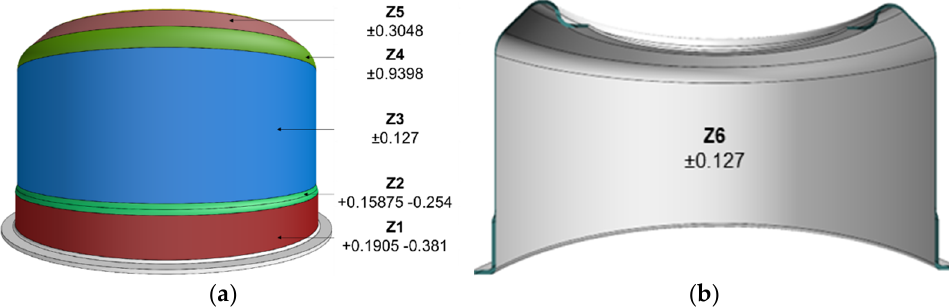
Figure 4. Characteristic zones of the component with specific thicknesses and variations in